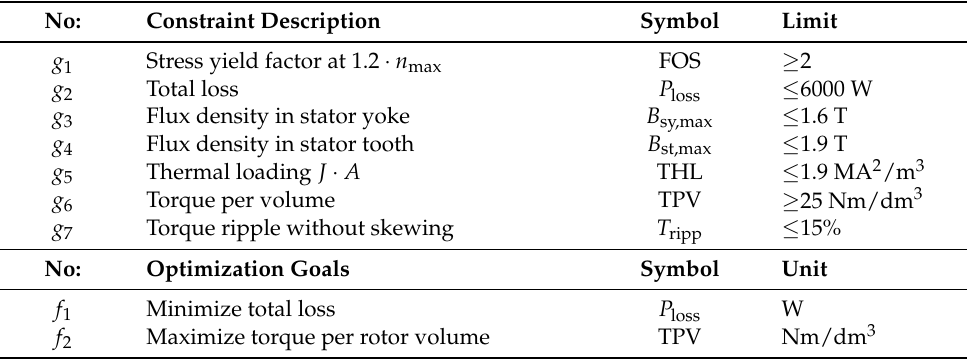
Table 2. Inequality constraints and optimization